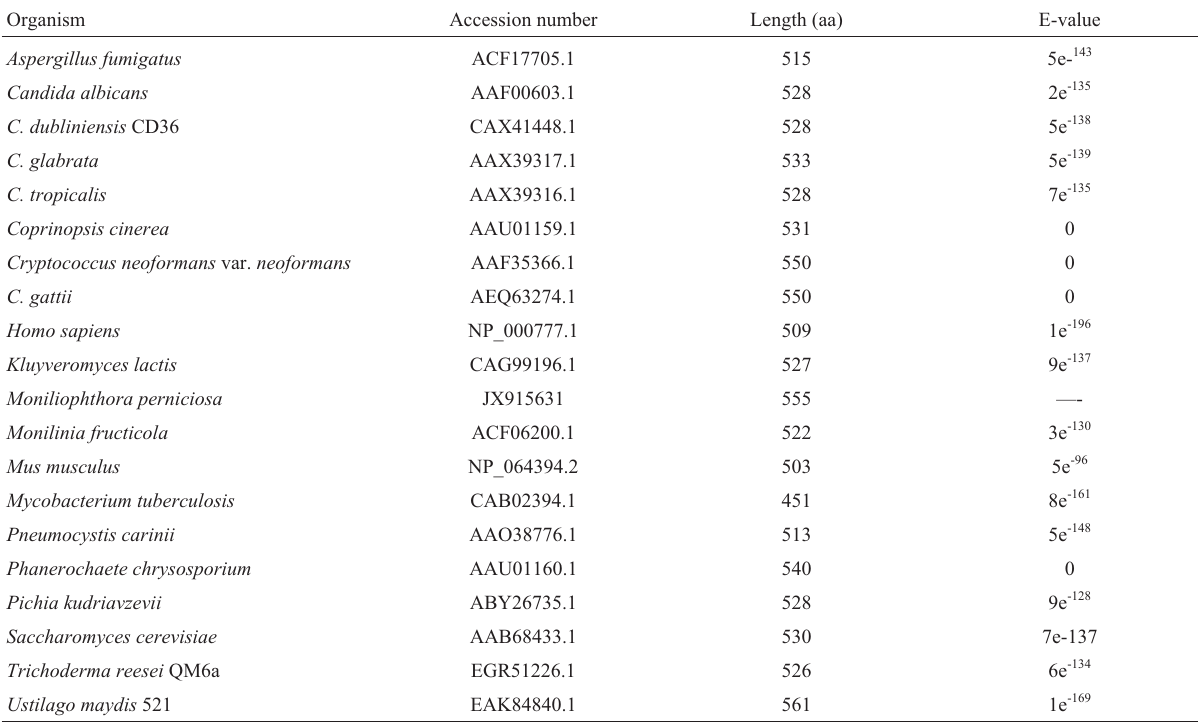
Table 1 - CYP51 proteins deposited in GenBank used for sequence and phylogenetic analyses.